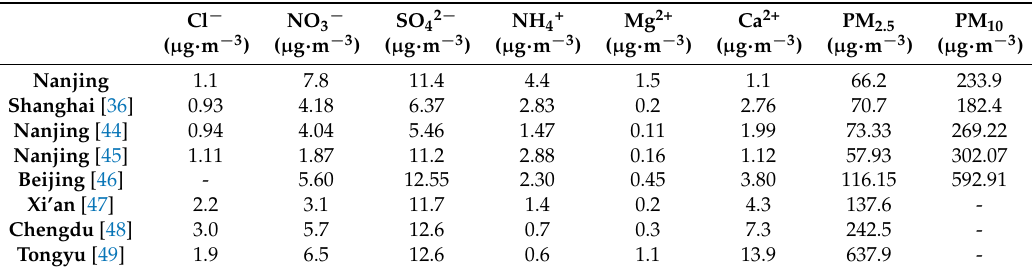
Table 2. Mass concentrations of PMs and water-soluble ions in PM 2.5